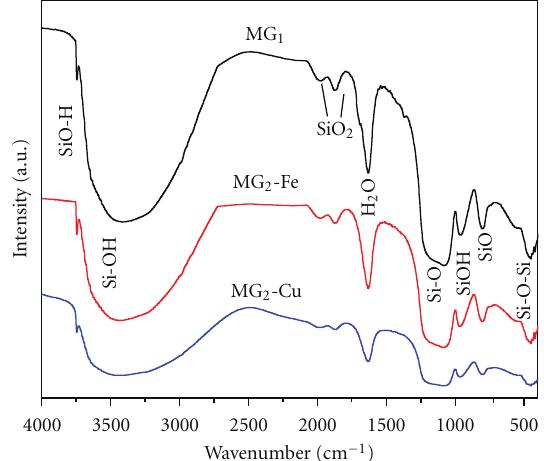
Figure 3: FT-IR spectra of MG 1 , MG 2 -Cu doped, and MG 2 -Fe